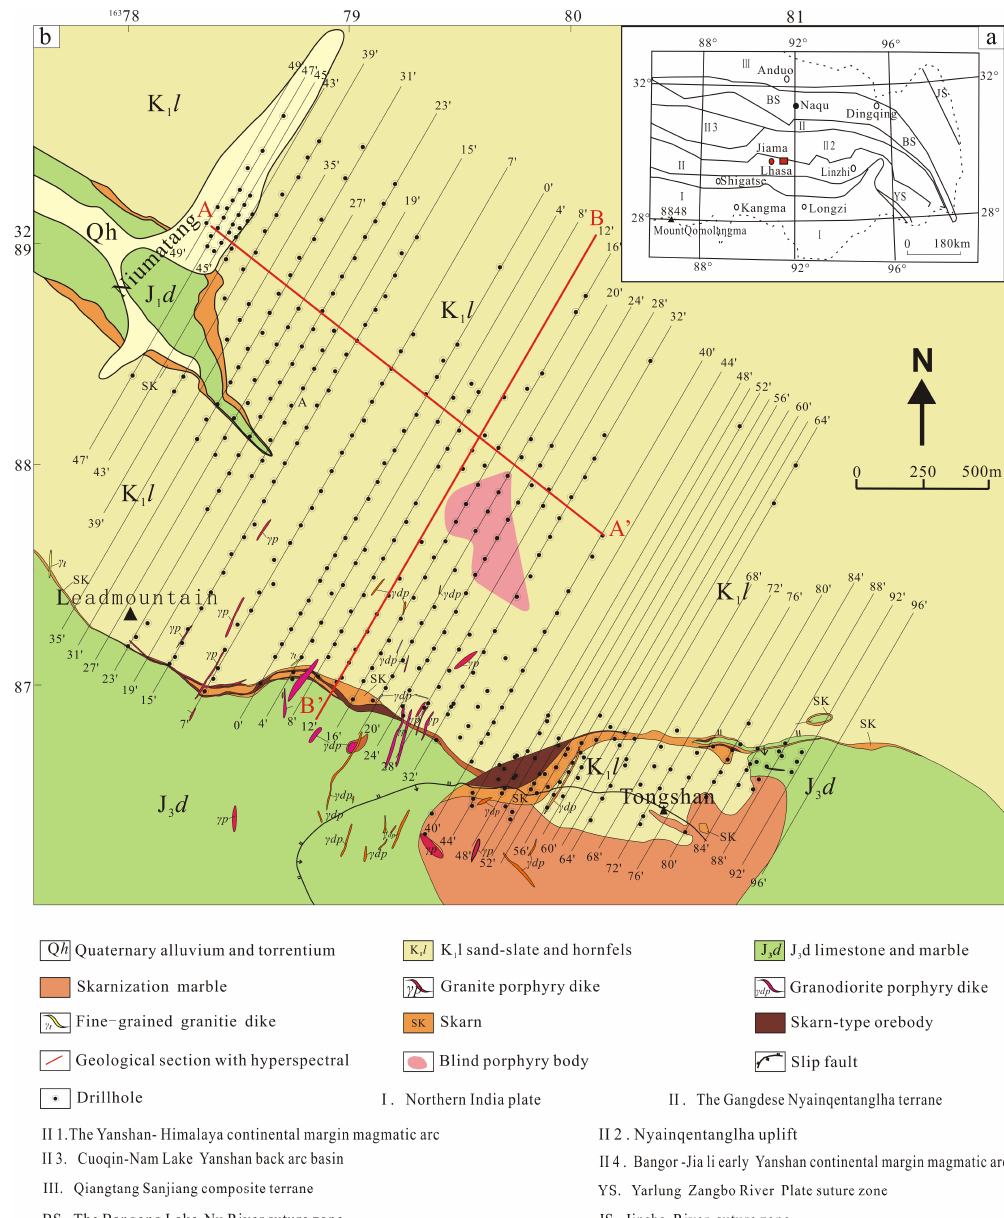
Figure 1. Geology of the Jiama Cu polymetallic ore deposit showing sedimentary and intrusive rocks, faults and the location of drill holes, including the two transects of drill holes measured by thermal infrared reflectance (TIR) spectra (red lines, “A-A’” and “B-B’”). (adapted from Tang et al. [38]). ( a ) Tectonic framework of the Tibetan Plateau. (adapted from Guo et al. [20]). ( b ) Geology of the Jiama Cu polymetallic ore deposit. (adapted from Tang et al. [38] ).